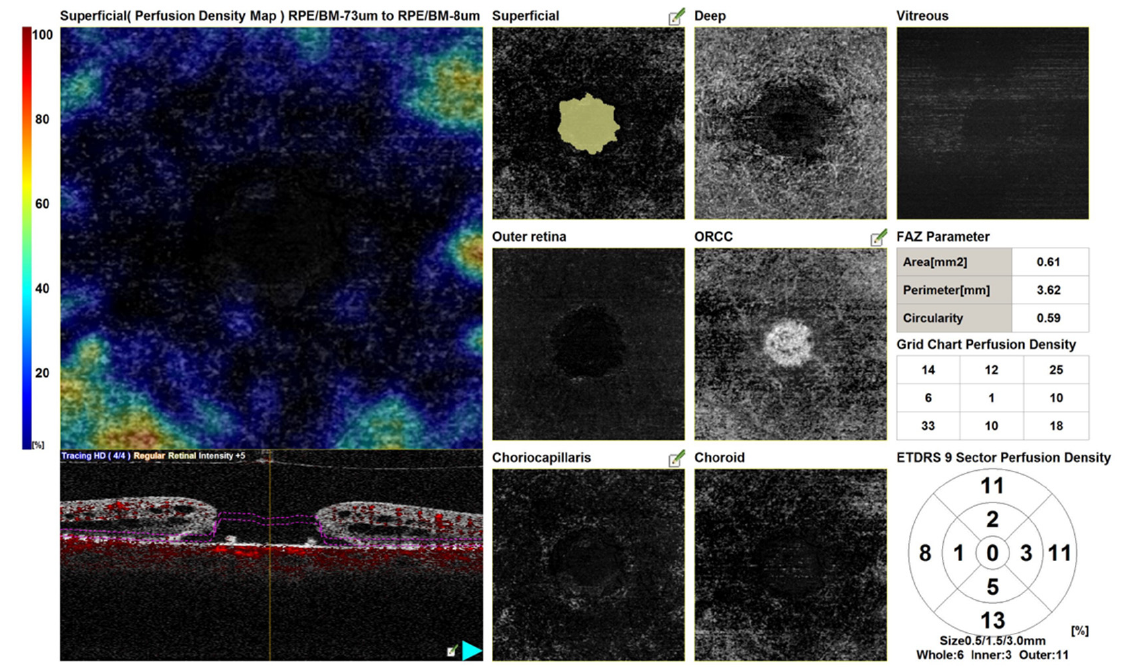
Figure 7. Optical coherence tomography angiography maps of a full-thickness macular hole.